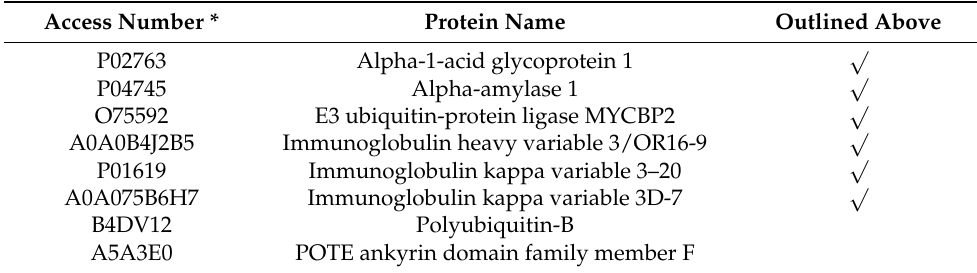
Table 1. Proteins detected exclusively in the samples treated with WGA